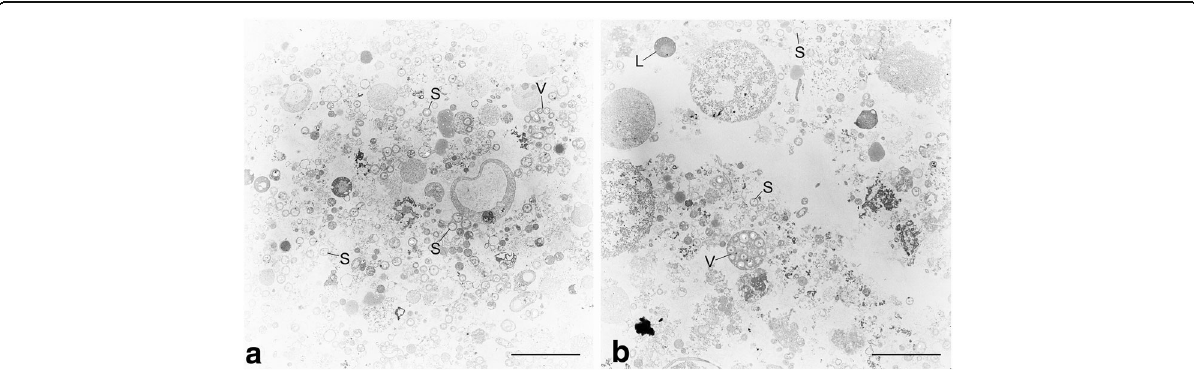
Fig. 1 Transmission electron micrographs of Candidatus Thioglobus thermophilus. B. thermophilus gill tissue was homogenized in a glass tissue grinder and subjected to crude density gradient centrifugation using Histodenz ™ gradient medium. Subsamples were taken from two visible bands and fixed for electron microscopy ( a and b ). Both subsamples contained numerous free symbiont cells (S) as well as some intact host vacuoles (V) containing several symbiont cells, besides various other cellular components and host tissue debris. L: Lipid drop or mucus. Scale bar: 5 μ m. Electron microscopy method details: samples were fixed in a ) 1% glutaraldehyde, 2% paraformaldehyde in IBS (imidazole-buffered saline; 0.49 M NaCl, 30 mM MgSO 4 *7H 2 O, 11 mM CaCl 2 *2H 2 O, 3 mM KCl, 50 mM imidazole) and b ) in 2.5% glutaraldehyde, 1.25% paraformaldehyde in IBS. After embedding in low-gelling agarose and postfixation in 1% osmium tetroxide in cacodylate buffer (0.1 M cacodylate; pH 7.0),